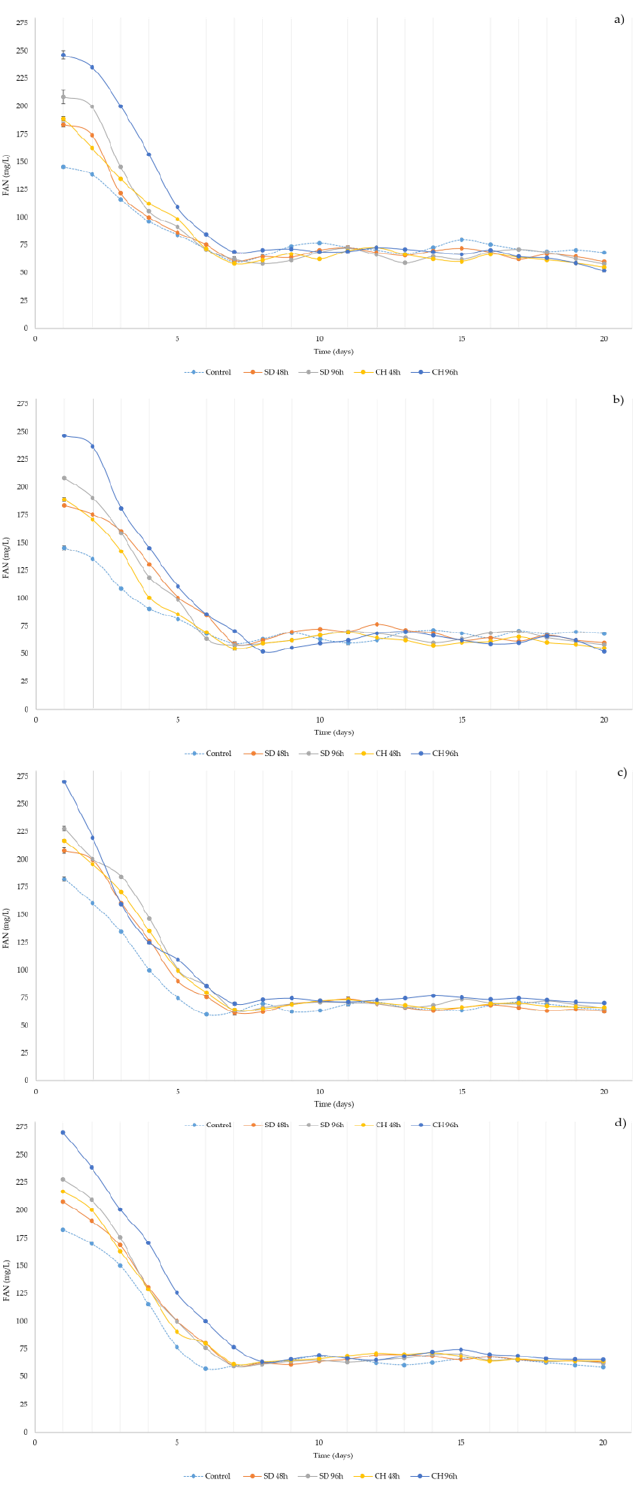
Figure 3. ( a–d ) Free amino nitrogen (FAN) concentration during grape must alcoholic fermentation without ( a , c ) and with ( b , d ) the presence of grape skins during two vintages (2018, a , b, and 2019, c , d ). Control: without over-ripening. SD48h: sun-dried grapes during 48 h. SD96h: sun-dried grapes during 96 h. CH48h: climatic chamber drying during 48 h. CH96h: climatic chamber drying during 96